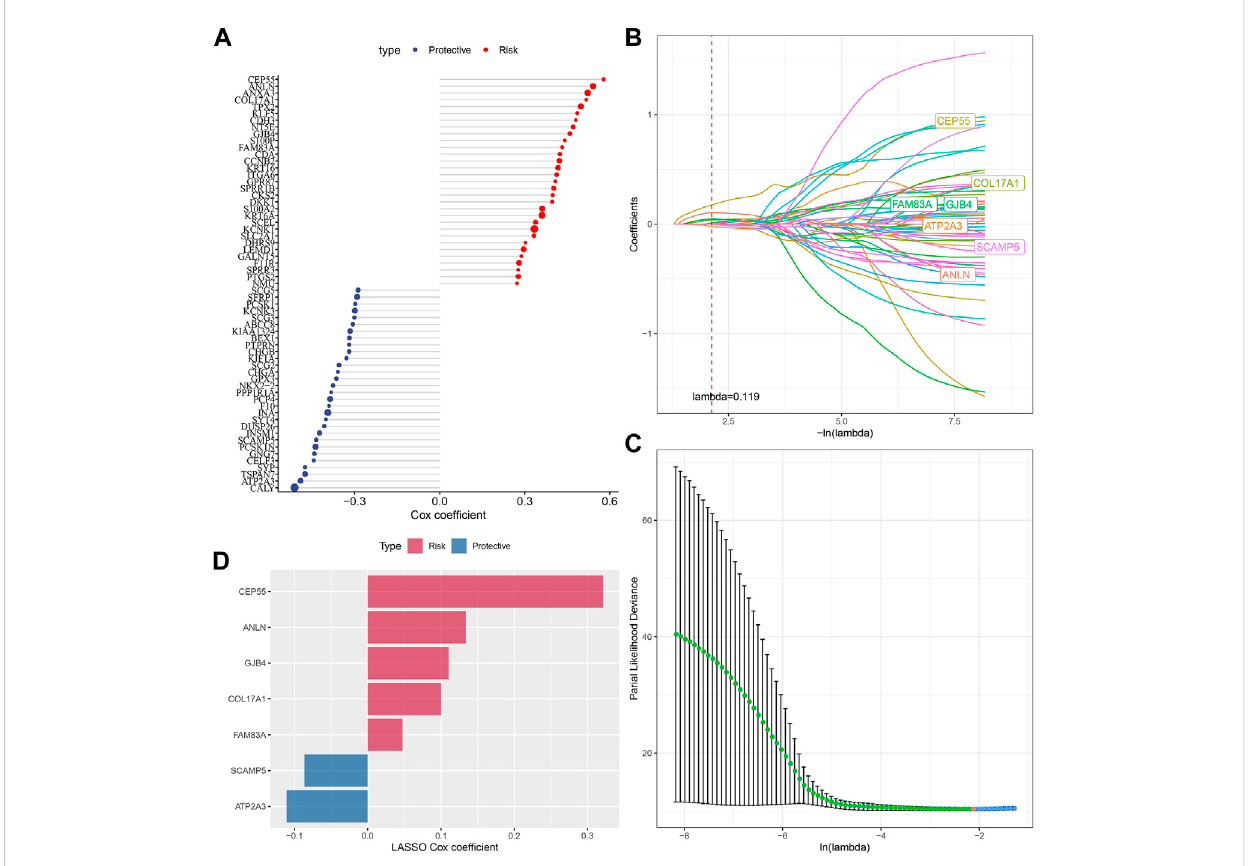
FIGURE 5 Screening of genes correlated with oxidative stress that affect prognosis. (A) Totally 61 candidates were screened from all the DEGs; (B) With the change of lambda, trajectory of each independent variable was shown; (C) Con fi dence interval under lambda; (D) Oxidative stress-related prognostic gene markers and the distribution of LASSO coef fi